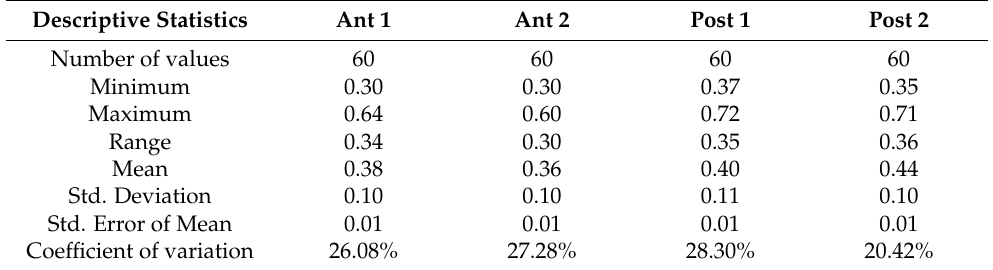
Table 4. Ultrasound thickness measurements of the superficial fascia of the forearm. Descriptive